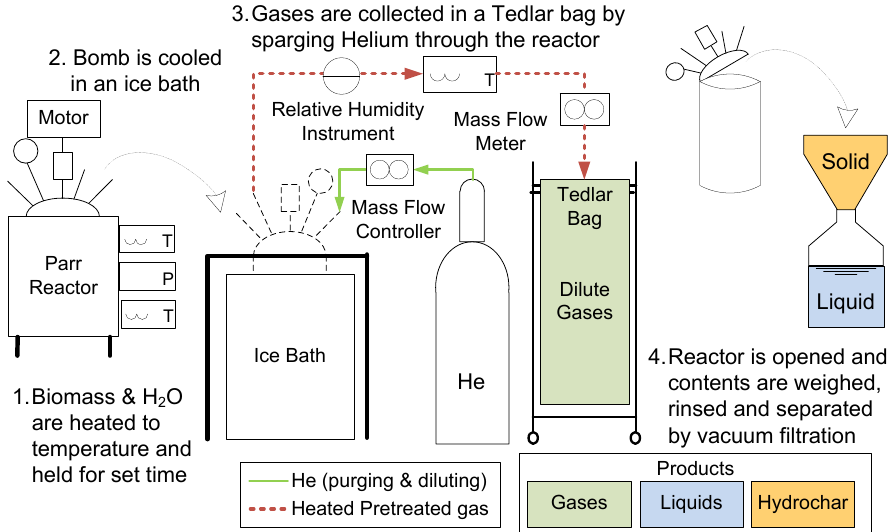
Figure 8. Flow diagram of HTC process and product